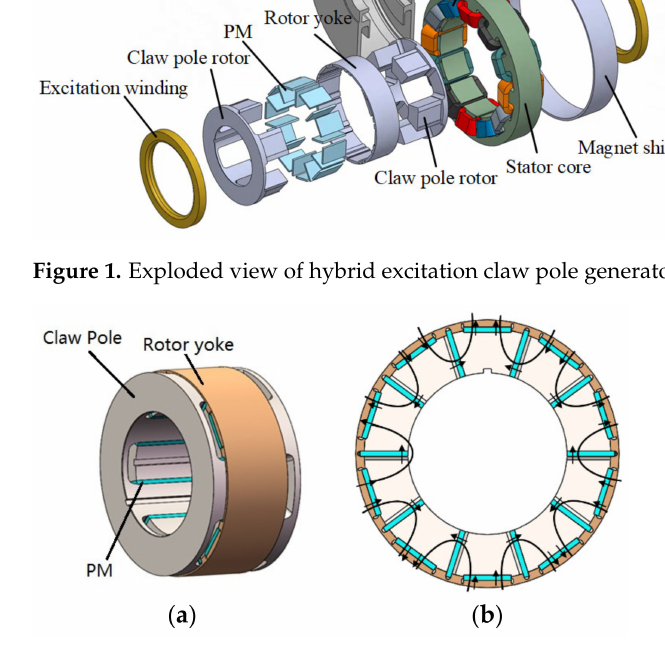
Figure 2. Rotor layout: ( a ) overview; ( b ) cross-section.